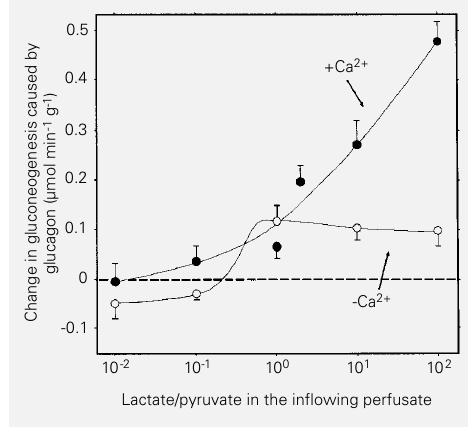
Figure 5 - Changes in oxygen uptake caused by gluca- gon in the presence (filled circles) and absence (open circles) of Ca 2+ and at different cytosolic NAD + -NADH redox potentials. The data are from the same experi- ments as described in the legend to Figure 4. The changes in oxygen uptake caused by glucagon are the differences between the new steady state in the pres- ence of glucagon and the steady state in the absence of glucagon. Each data point represents the mean of 3 to 5 liver perfusion experiments. The vertical bars rep- resent the standard errors of the mean. For the control curve (filled circles), the traced line corresponds to a parabolic regression line, optimized by means of a least- squares procedure. The regression line was y ^ = -0.116 + 0.0267x + 0.0156x 2 , with x = log (lactate/pyruvate x 10 3 ). The parabolic correlation coefficient was